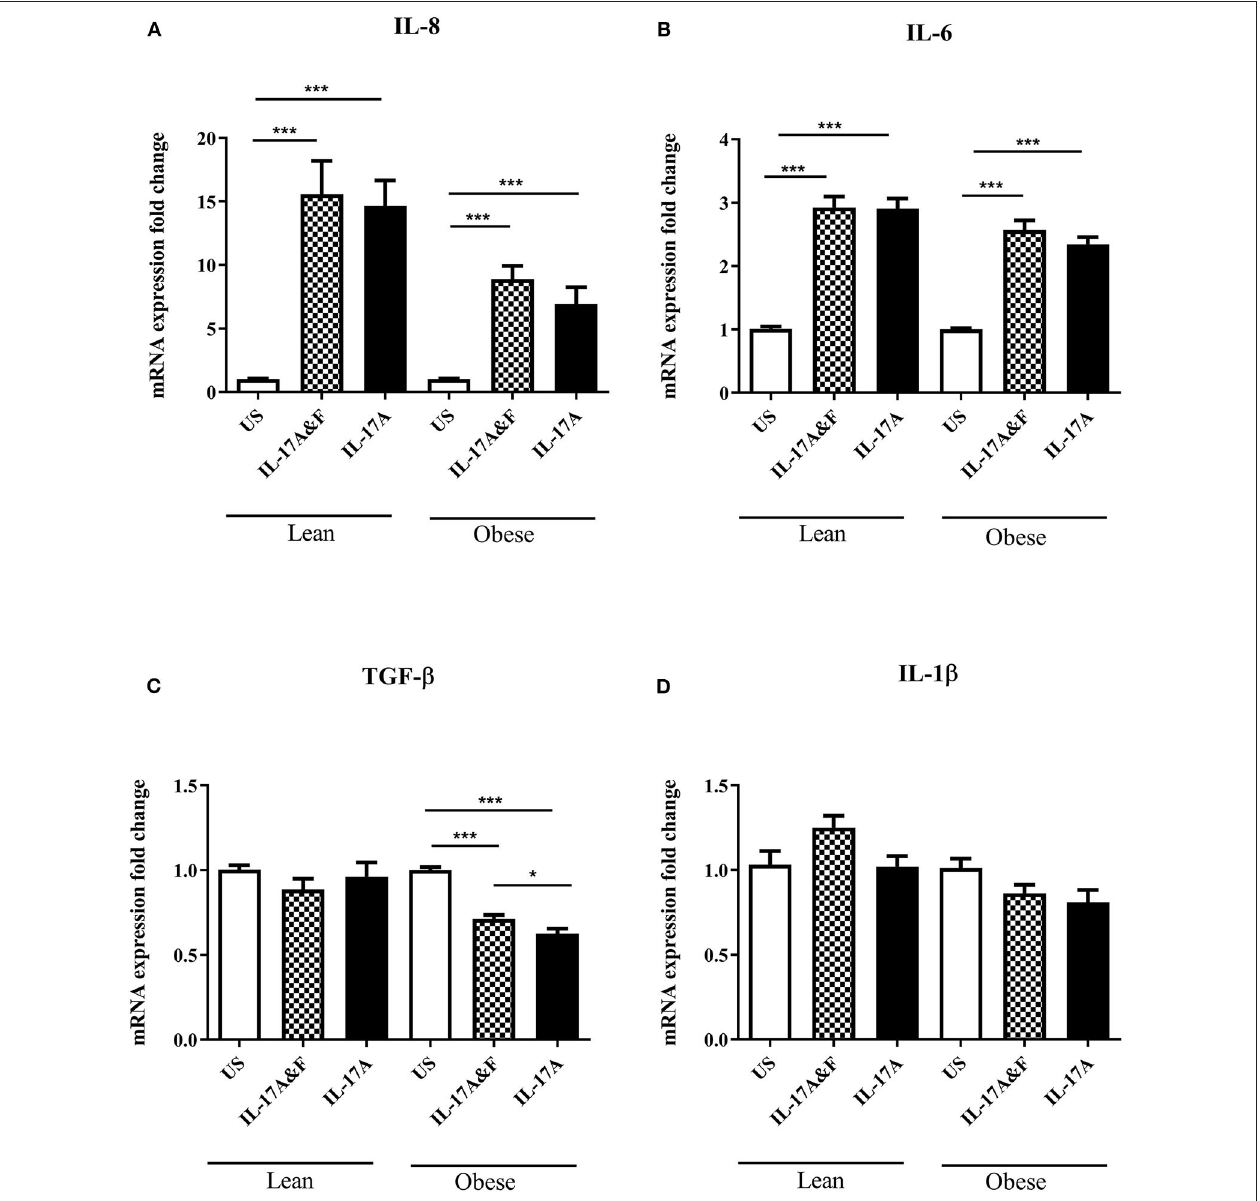
FIGURE 4 | Stimulation with IL-17A&F and IL-17A alone induces changes in mRNA expression of inflammatory mediators in adipocytes from lean and obese subjects. qRT-PCR analysis of detected mRNA expression of inflammatory markers: IL-8 (A) , IL-6 (B) , TGF- β (C) , IL-1 β (D) in mature adipocytes after 48h stimulation with combination of IL-17A&F or IL-17A alone. n = 4 lean subjects, n = 3 obese subjects, One-way ANOVA, Mean ± SE; * P < 0.05, *** P <